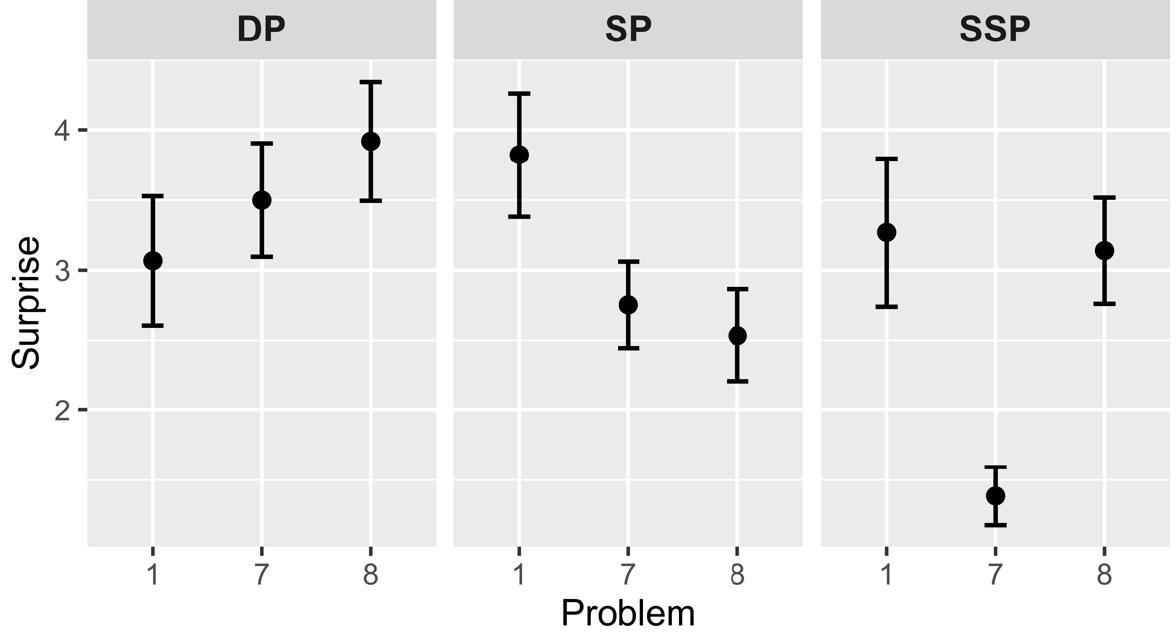
Figure 3. Subjective ratings of surprise in different groups (1—unsurprise solution, 7—surprise). Note. Vertical bars denote standard errors. DP—different principle group, SP—same principle group, SSP—same structure and principle group.